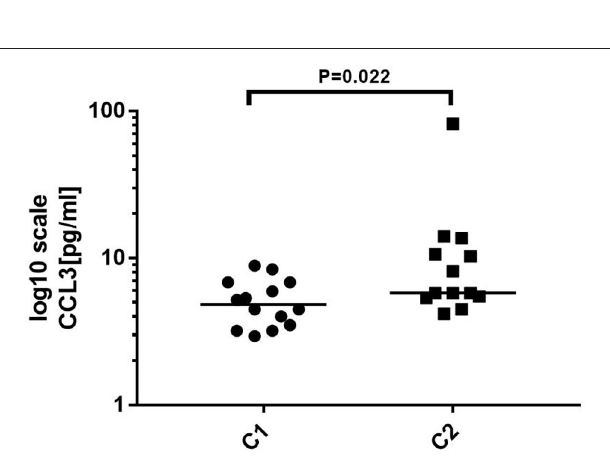
FIGURE 5 | Comparison of the level of cytokines/chemokines at different antibody titers. C1: antibody titer in cerebrospinal fluid (CSF) was negative ∼ 1:100, n = 14. C2: Antibody titer in CSF was more than 1:100 ∼ 1:320, n = 13. Mann–Whitney U test was used. The level of CCL3 was significantly increased in C2 compared to that in C1 ( p <